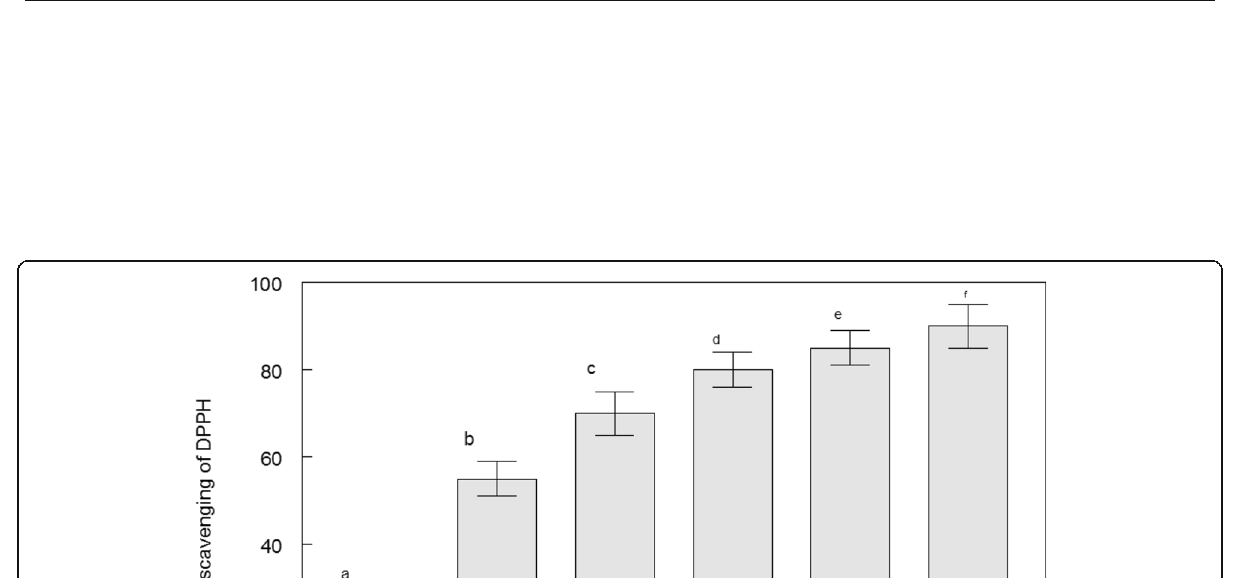
Fig. 2 Inhibitory effect of Terminalia chebula on lipid peroxidation induced by 10 μ M Fe (II) and 5 μ M sodium nitroprusside in egg yolk. Values represent the means of three separate experiments in duplicate ± SD. p < 0.05 is significantly different from control by DMRT. Values in figures which share different letters are significantly ( p < 0.05) different from each other by